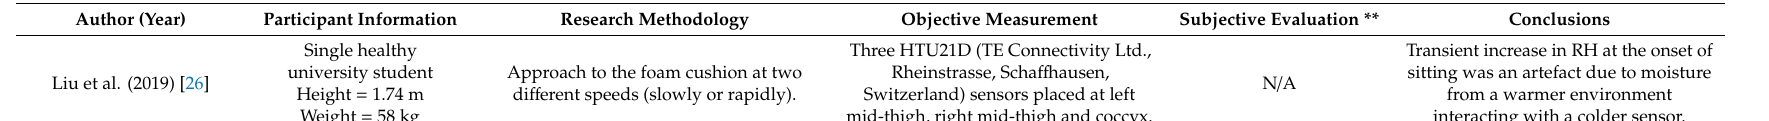
Table 1. Overview of studies on microclimate measurements at the user-seat interface and subjective